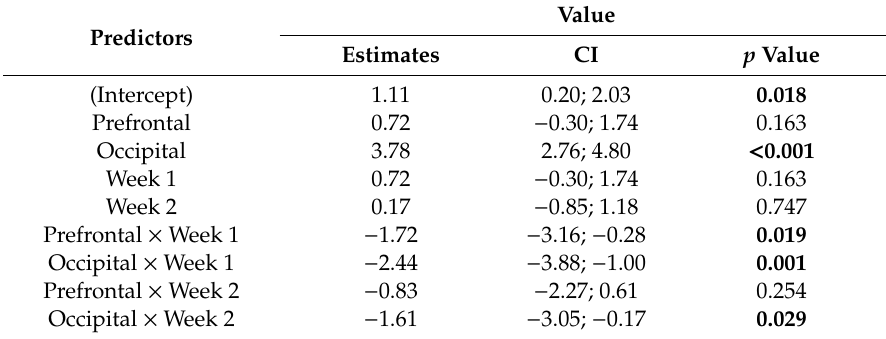
Table 4. Mixed-e ff ect model for the number of severe migraine days per week with the ‘patient ID’ being considered as random e ff ect and the interaction between the brain stimulation condition and time as fixed e ff ect.